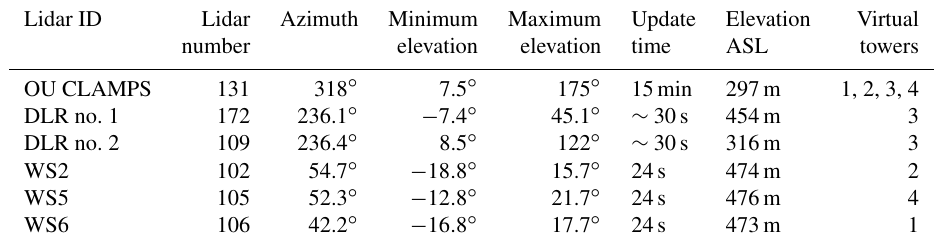
Table 1. Characteristics of the RHI scans performed by each DL used in this study and the virtual towers they were used for. Lidar ID Lidar Azimuth Minimum Maximum Update Elevation Virtual number elevation elevation time ASL towers OU CLAMPS 131 318 ◦ 7.5 ◦ 175 ◦ 15min 297m 1, 2, 3, 4 DLR no. 1 172 236.1 ◦ − 7 . 4 ◦ 45.1 ◦ ∼ 30s 454m 3 DLR no. 2 109 236.4 ◦ 8.5 ◦ 122 ◦ ∼ 30s 316m 3 WS2 102 54.7 ◦ − 18 . 8 ◦ 15.7 ◦ 24s 474m 2 WS5 105 52.3 ◦ − 12 . 8 ◦ 21.7 ◦ 24s 476m 4 WS6 106 42.2 ◦ − 16 . 8 ◦ 17.7 ◦ 24s 473m